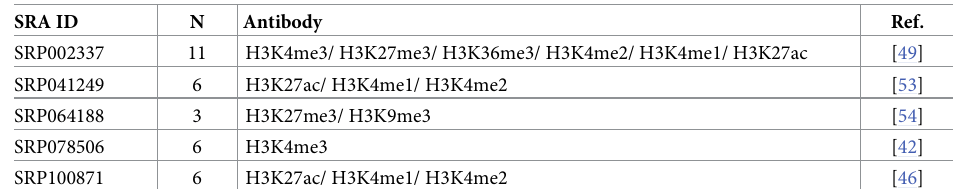
Table 3. Histone modification data.